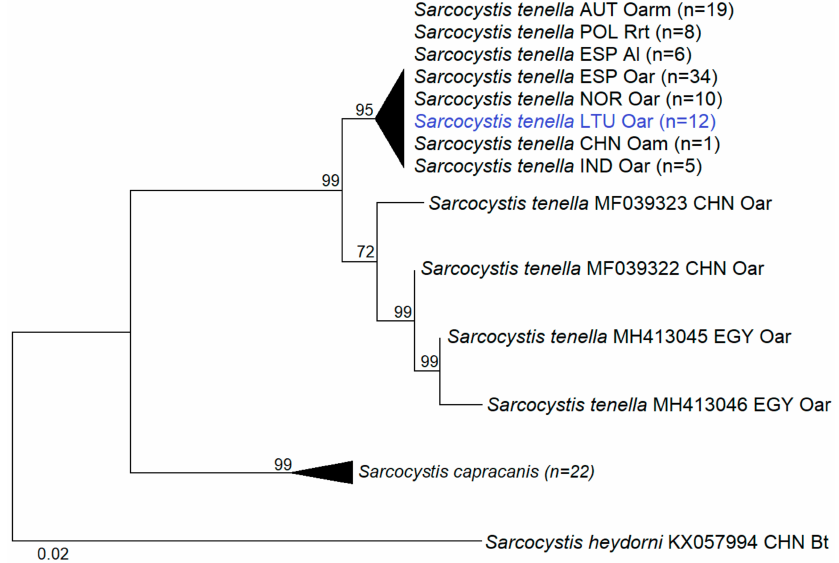
Figure 3. Phylogenetic trees of selected Sarcocystis spp. based on cox1 sequences showing the genetic relatedness of isolated sarcocysts to S . tenella . The tree was rooted on S . heydorni . The figures next to the branches show the bootstrap support values. Sequences obtained in the present study are marked in blue. The final alignment consisted of 3 taxa, 122 sequences, and 863 aligned nucleotide positions. The Kimura 2-parameter + G + I model was chosen for the phylogenetic analysis. AUT: Austria, CHN: China, EGY: Egypt, ESP: Spain, IND: India, LTU: Lithuania, NOR: Norway, POL: Poland, Al: Ammotragus lervia , Bt: Bos taurus , Oar: Ovis aries , Oarm: Ovis aries musimon , Oam: Ovis ammon , Rrt: Rupicapra rupicapra tatrica , n : number of